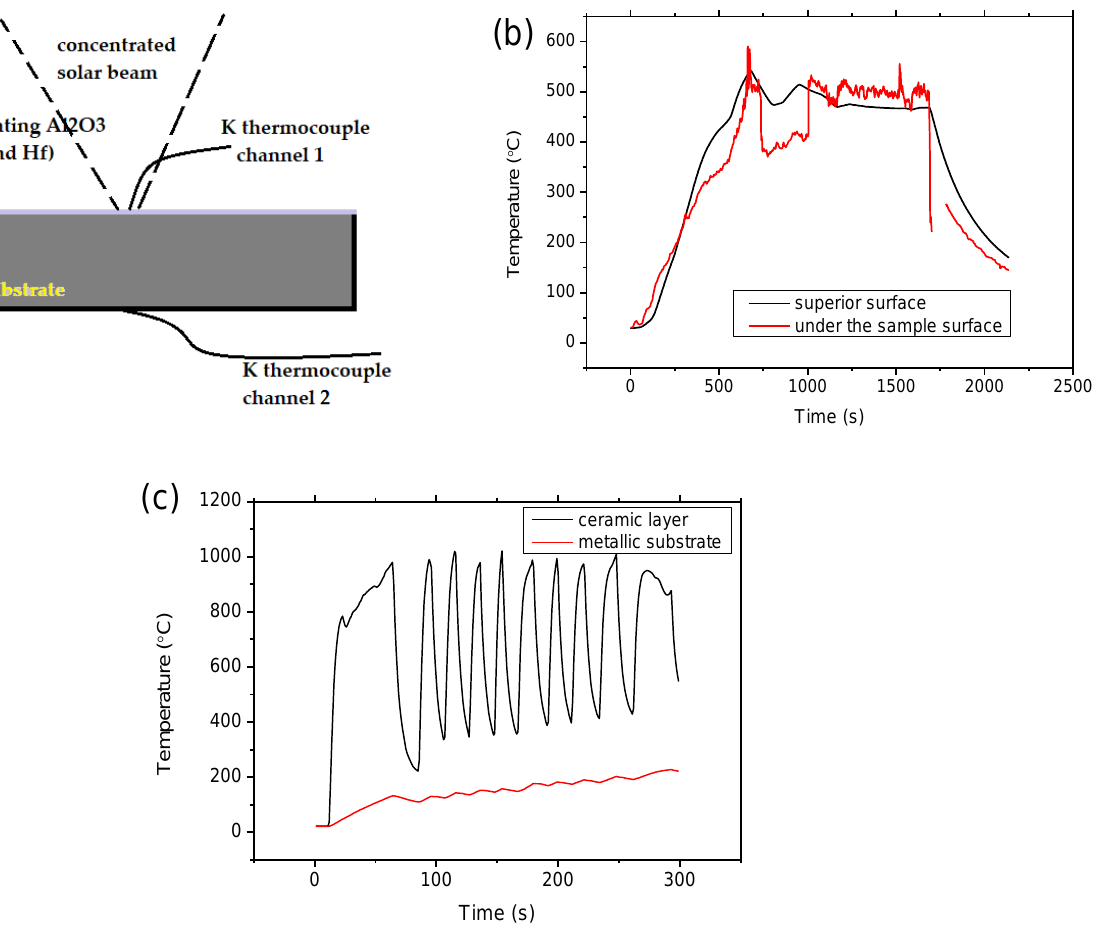
Figure 2. Temperature variation registration. ( a ) schematic set-up; ( b ) metallic substrate and ( c ) me- tallic substrate and ceramic layer lic substrate and ceramic